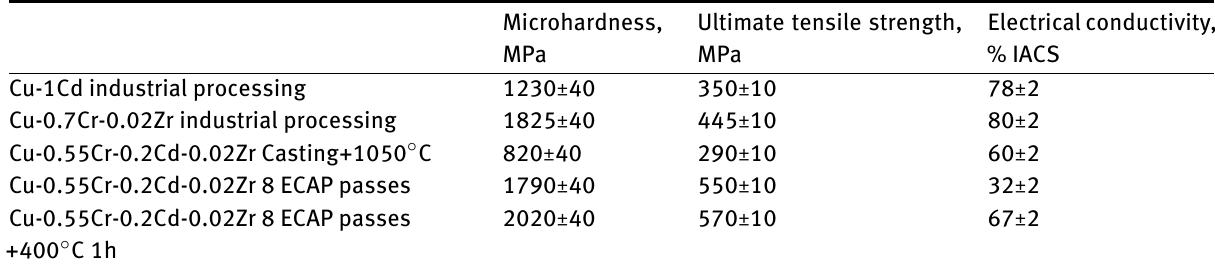
Table 4: Strength properties and electrical conductivity